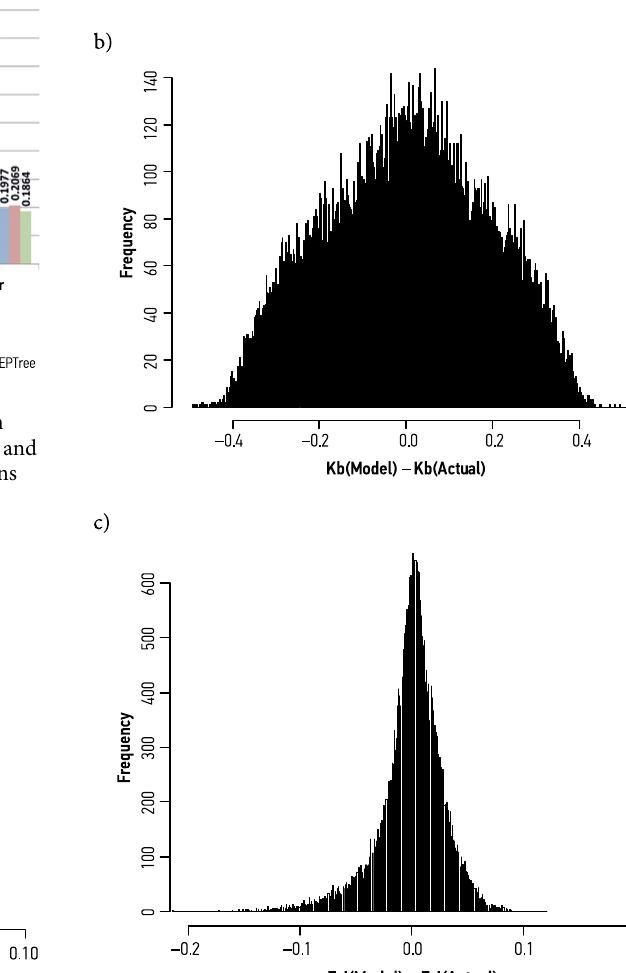
Fig. 8. Histograms of prediction errors with Bagging_M5P: a – E ac ; b – K b (using E ac and E ri as inputs); c – E ri